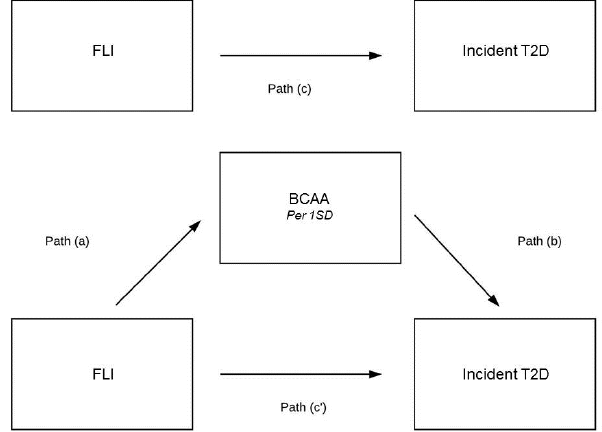
Figure 2. Mediation analysis on the association of FLI with incident type 2 diabetes. (a)–(c) are the